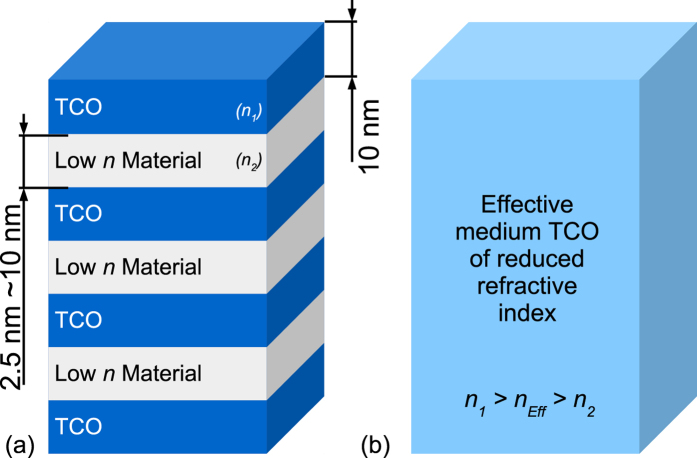
Conceptual Schematic of Superlattice.(a) The structure of the superlattices. (TCO layers (n1) of 10 nm interspersed with low n (n2) layers of 2.5 nm to 10 nm thickness). (b) The optical response of the superlattice, namely an effective medium of refractive index index n1 > n > n2.